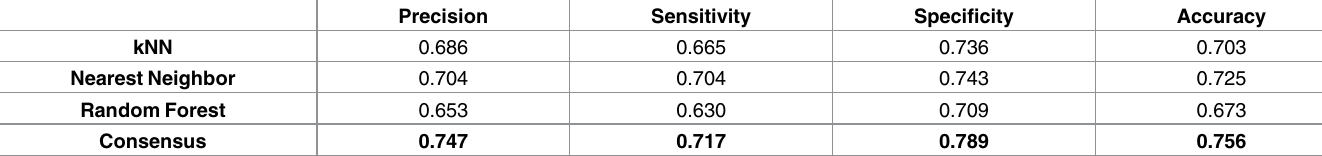
Table 2. Validation results for the test